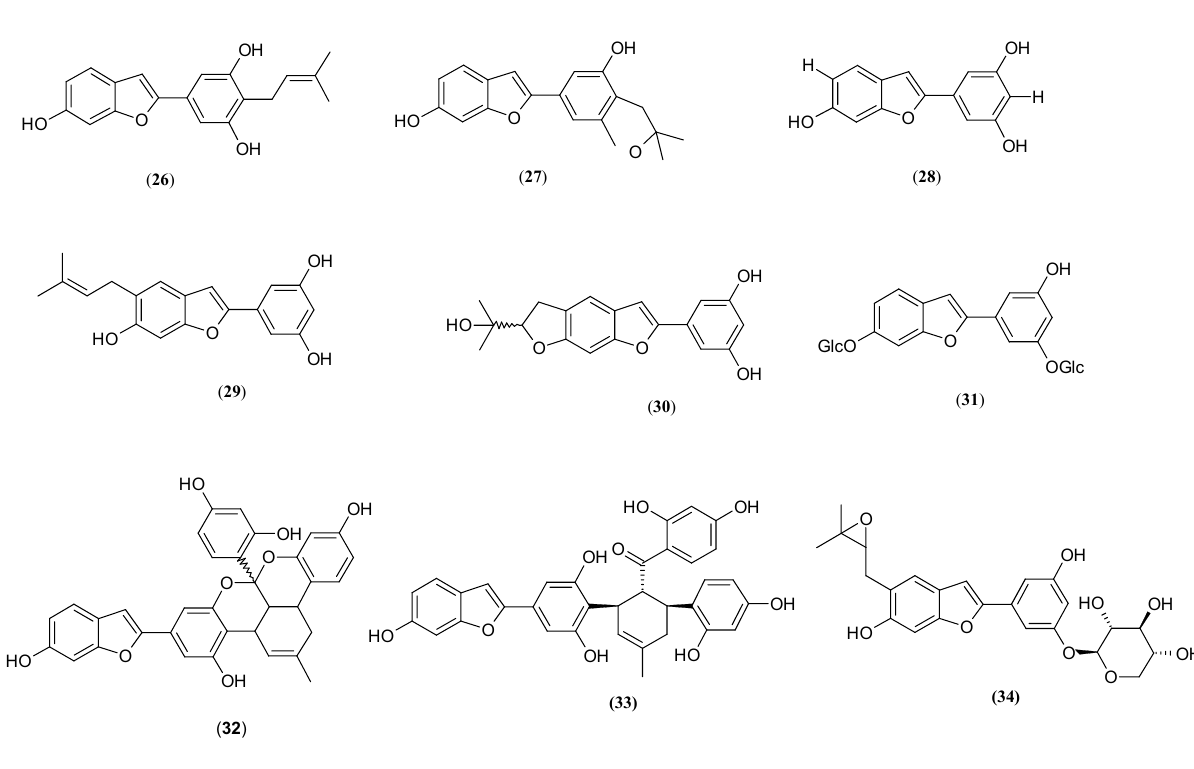
Figure 7. Structures of benzofurans: moracin C ( 26 ), moracin D ( 27 ), moracin M ( 28 ), moracin N ( 29 ), moracin O ( 30 ), mulberroside F ( 31 ), mulberrofuran G ( 32 ), mulberrofuran J ( 33 ), moracinoside M ( 34 ) with tyrosinase inhibitory activity isolated from genus Morus .